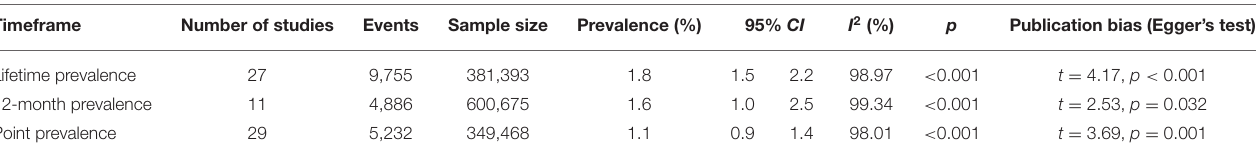
TABLE 5 | Pooled prevalence of MDD in